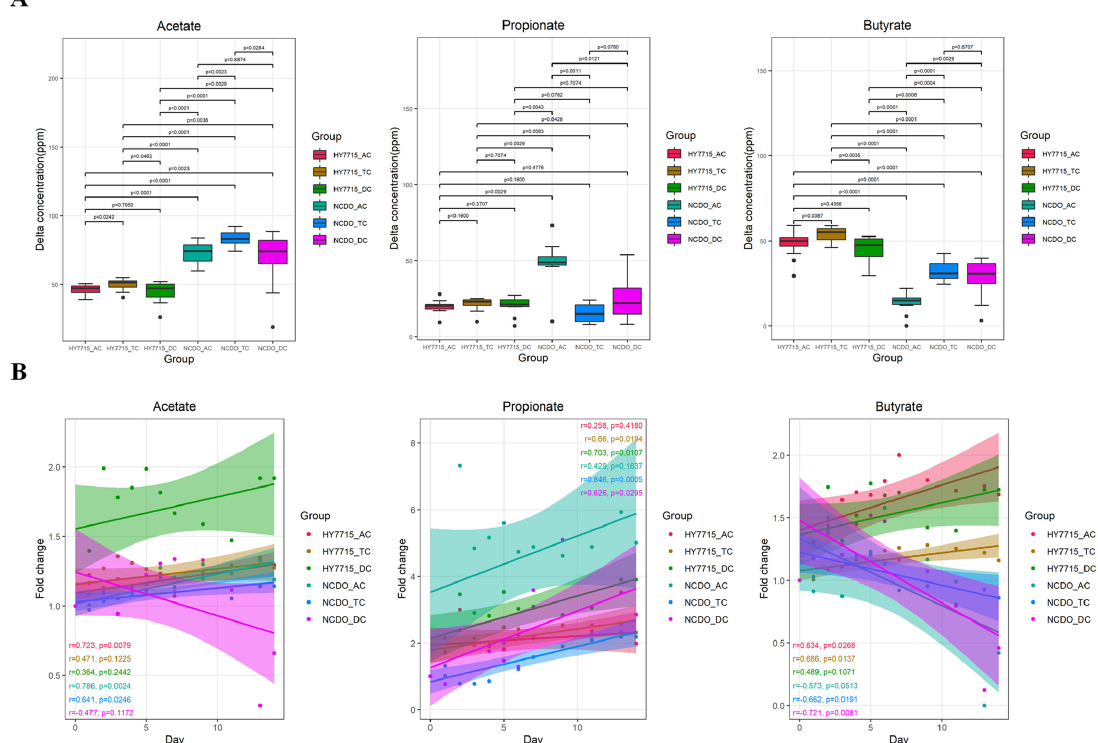
Figure 2. Changes in short-chain fatty acids (acetate, propionate, and butyrate) in the fecal inoculum with strains HY7715 and NCDO175: ( A ): boxplot of changes in the short-chain fatty acid content during the 14 d treatment period compared to the 0 day value of the HY7715 and NCDO treatment groups. Statistical analysis was performed using the Kruskal–Wallis nonparametric test. ( B ): Results of the correlation analysis of short-chain fatty acids vs. date fold change. The trend slope R-value indicates the correlation coefficient and the shaded range around the straight line is twice the standard deviation (AC—ascending colon; TC—transversal colon; DC—descending colon).